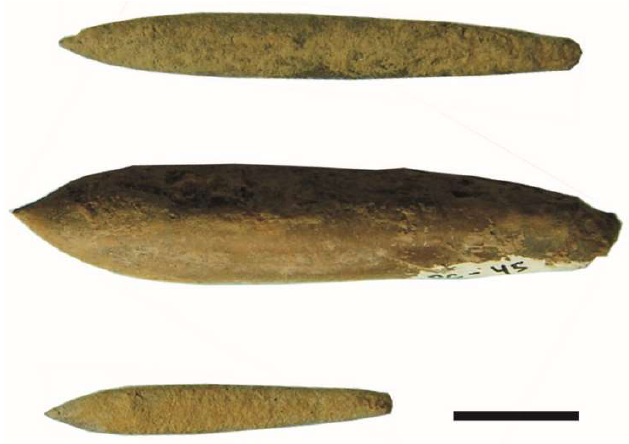
Figure 1. Specimens of belemnites ( Hibolithes ) from the upper Oxfordian (Upper Jurassic)